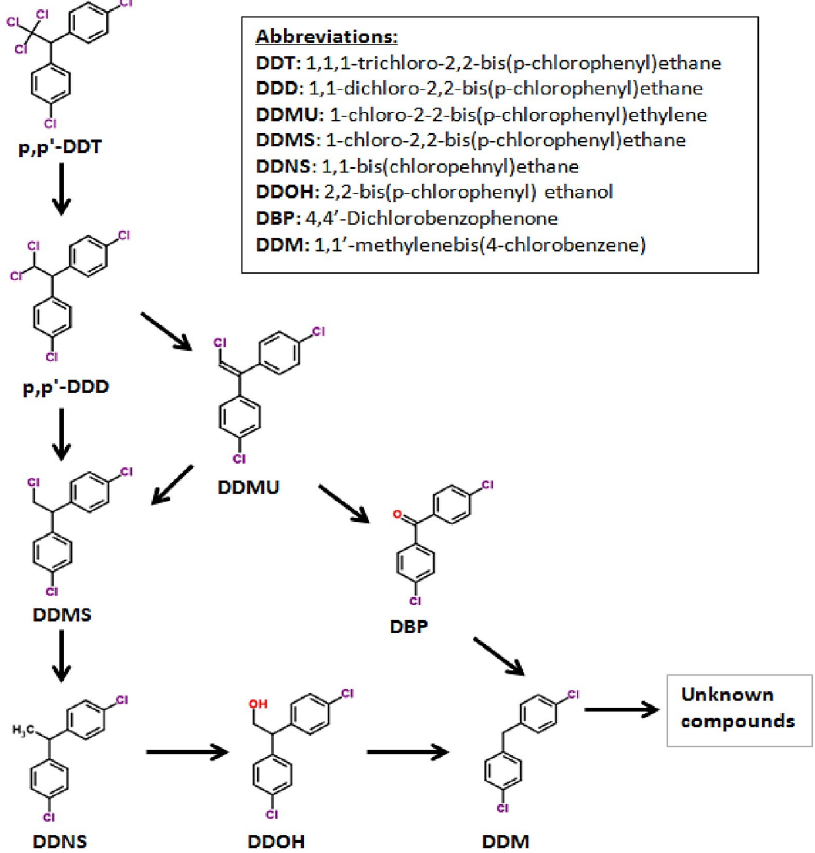
Figure 5. Degradation pathway of p,p-dichlorodiphenyltrichloroethane (DDT) using zero-valence iron. Reprinted from [42]. Copyright (2016), with permission from Elsevier.